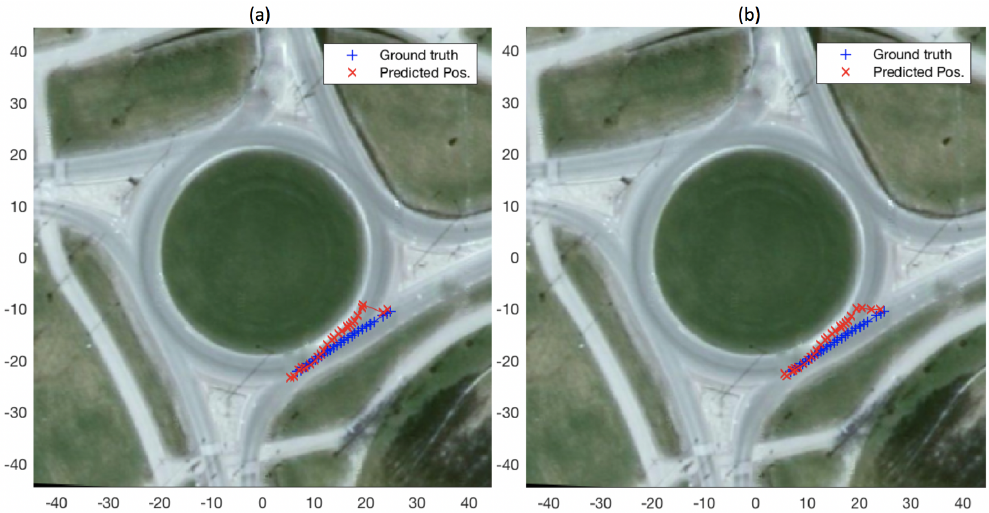
Figure 9. Comparison in state prediction when all reference trajectories are used ( b ); and when only the reference trajectories belonging to the winning (i.e., belonging to the estimated exit-direction at any given time) class are used ( a